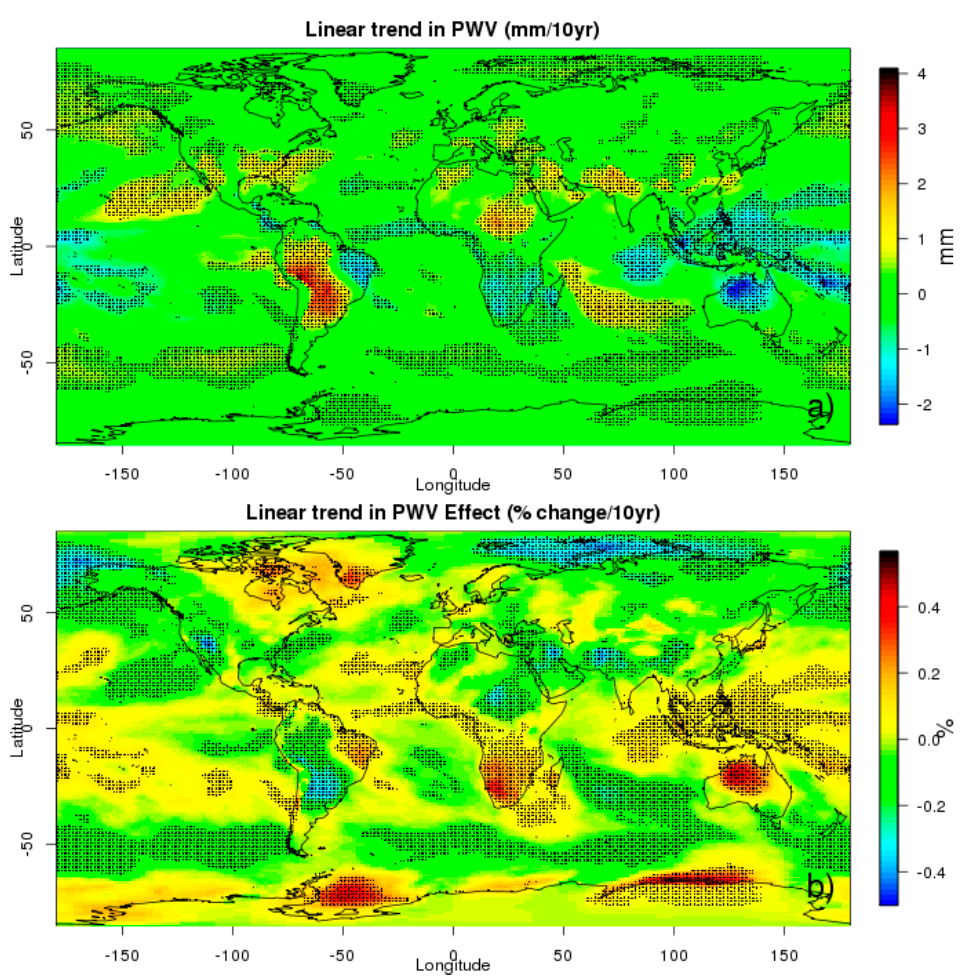
Figure 12. Global spatial distribution of linear trend per decade (PWV ( a ) and PWV effect ( b )). Pixels with levels of significance p < 0.05 are marked with a black dot.